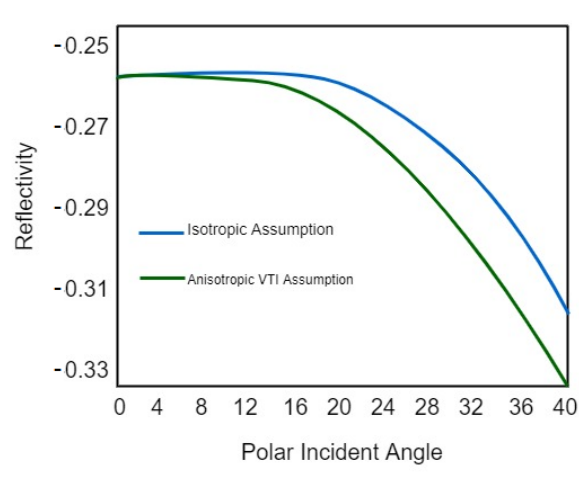
Figure 1. A plot of the reflection coefficient on the Y-axis versus the angle of incidence on the X-axis. The blue and green lines represent the reflectivities obtained based on the isotropic and anisotropic assumptions,